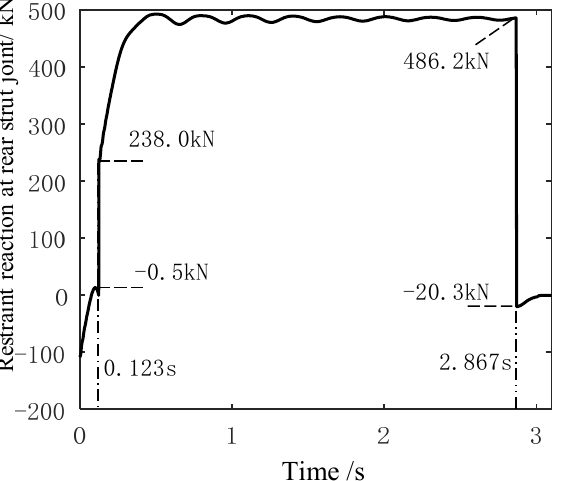
Figure 10. Time versus restrained reaction force at the catapult rod joint.